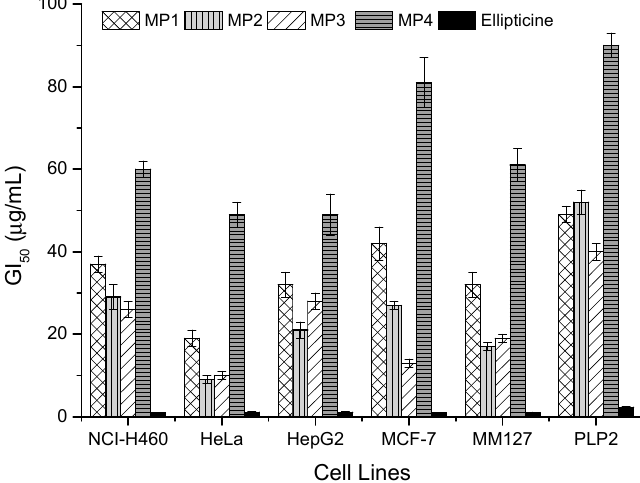
Figure 2. Cytotoxic activity of propolis samples on cell lines expressed in GI 50 values ( µ g / mL) (mean ± SD, n = 2). GI 50 values correspond to the extract concentration achieving 50% of growth inhibition in human tumor cell lines or in liver primary culture PLP2.